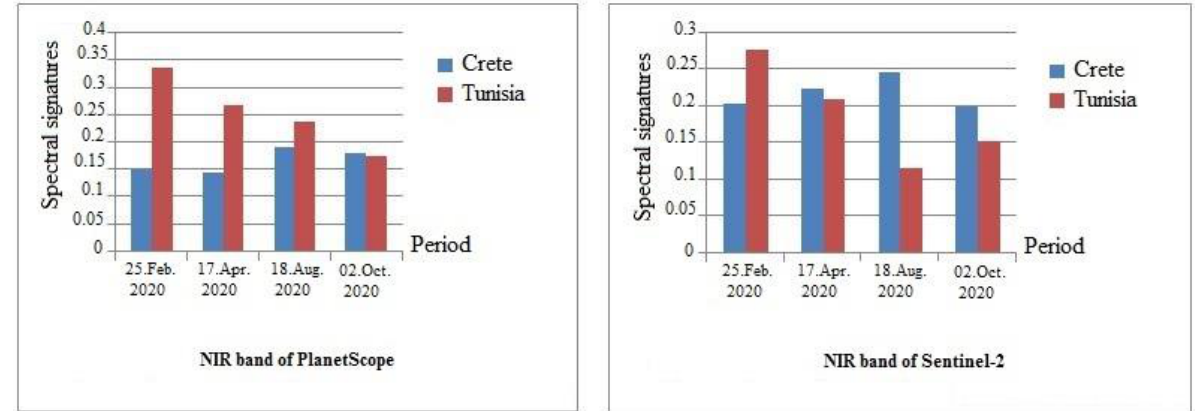
Figure 5. Spectral signature of OMW disposal areas.